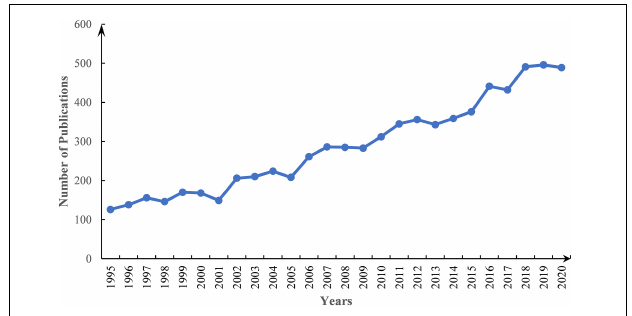
FIGURE 1 | Number of publications of each year from 1995 to